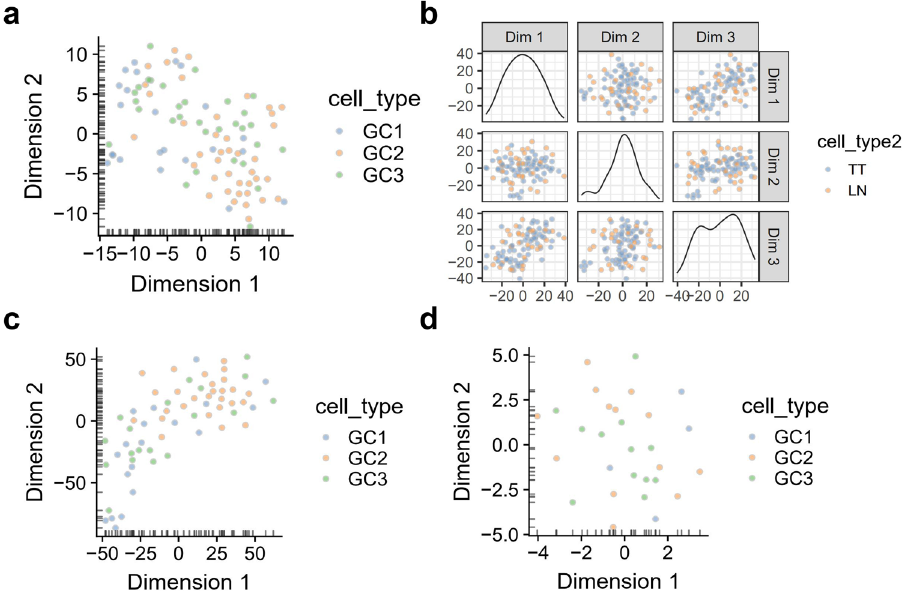
Figure 2. ( a ) T-SNE was plotted to present the distribution of the single cells from three patients in all primary tumour tissues. ( b ) Unsupervised T-SNE showing the separation of carcinoma cell groups. ( c ) In terms